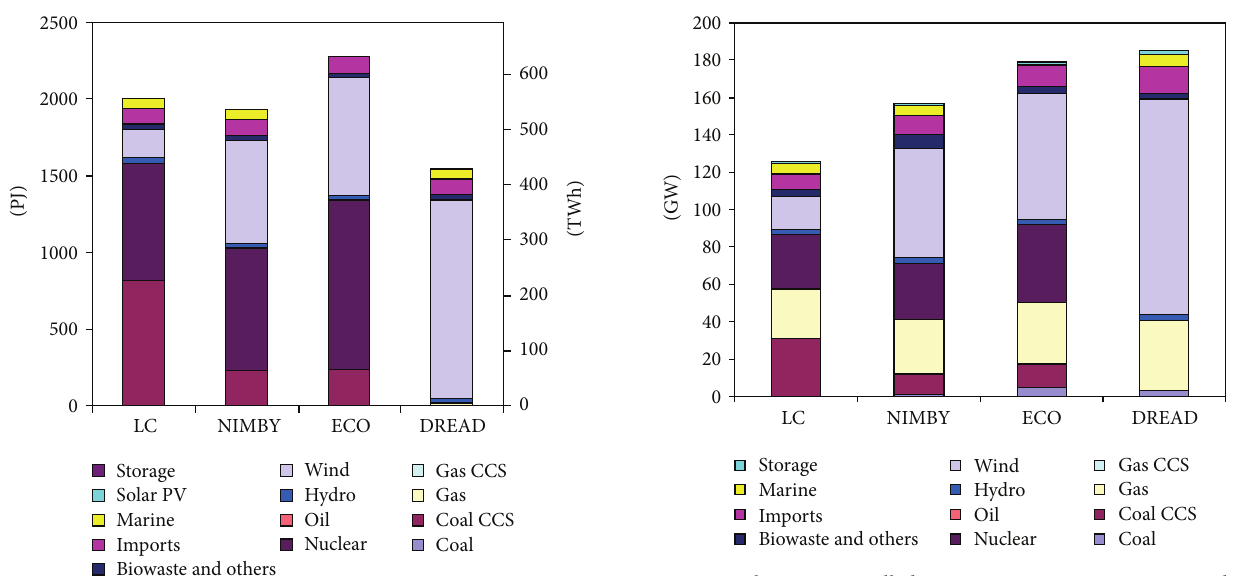
Figure 2: Electricity generation in 2050. Scenarios are the low carbon (LC) baseline and the three socio-environmental forms (NIMBY, ECO, and DREAD).